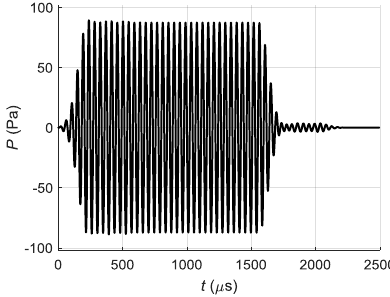
Figure 15. Total acoustic pressure signal P at the point P P .